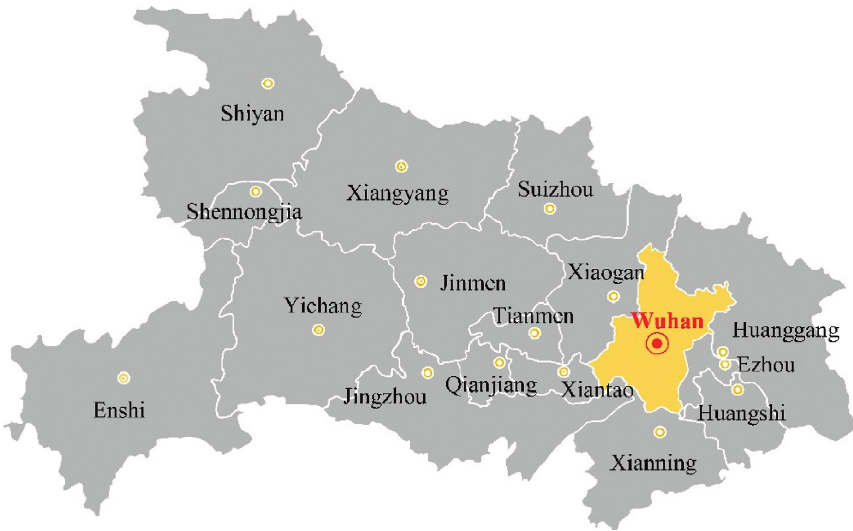
Figure 2: Wuhan and other 16 cities in the province of